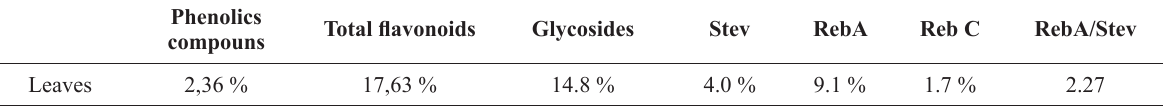
Total glycoside content (stevioside and rebaudioside A and C) from Stevia UEM-13. Phenolics